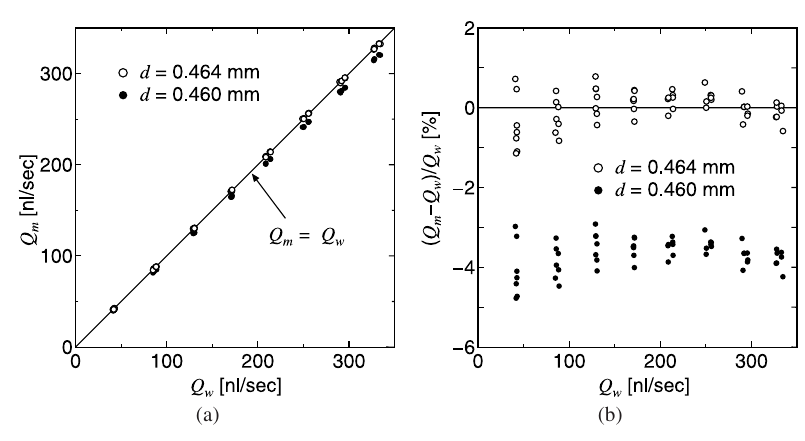
Fig. 7 Relation between the flow rate Q m given by Eq. (1) adopting the measured pressure P m and the flow rate Q w measured using gravimetric technique.